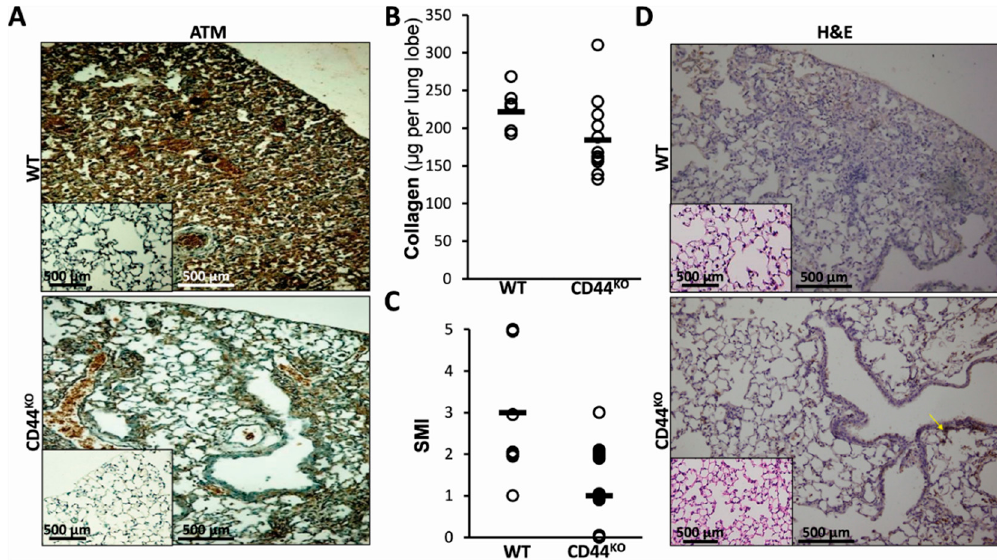
Figure 5. Normal lung regeneration following bleomycin-injury in chimeric-CD44 KO mice, compared to congenic-controls. ( A ) ATM staining in lung tissue sections from C57BL/6 WT vs. chimeric-CD44 KO mice at day 14 of bleomycin and control-saline (inserts). Representative of 4–5 sections in 3 separate experiments with similar results, n = 7–10. ( B ) Graphical presentation of Sircoll-collagen assay and ( C ), of a semi-morphological index (SMI) of H&E staining (see D ), at day 14 post-BLM in WT and CD44 KO . Bars ( ▬ ) represent median score. Three lung sections were scored from each animal, using a grading scheme as follows: grade 0 – normal tissue; grades 1–5 were used for animals with regenerated tissue (grade 0 to 1) or pulmonary inflammation and fibrosis, with higher grades (2 to 5) indicating more severe lesions [24]. Representative results from three independent experiments. For all comparisons, p < 0.05. ( D ) Hematoxylin-eosin (H&E) staining at day 14 post-BLM, in WT and CD44 KO murine